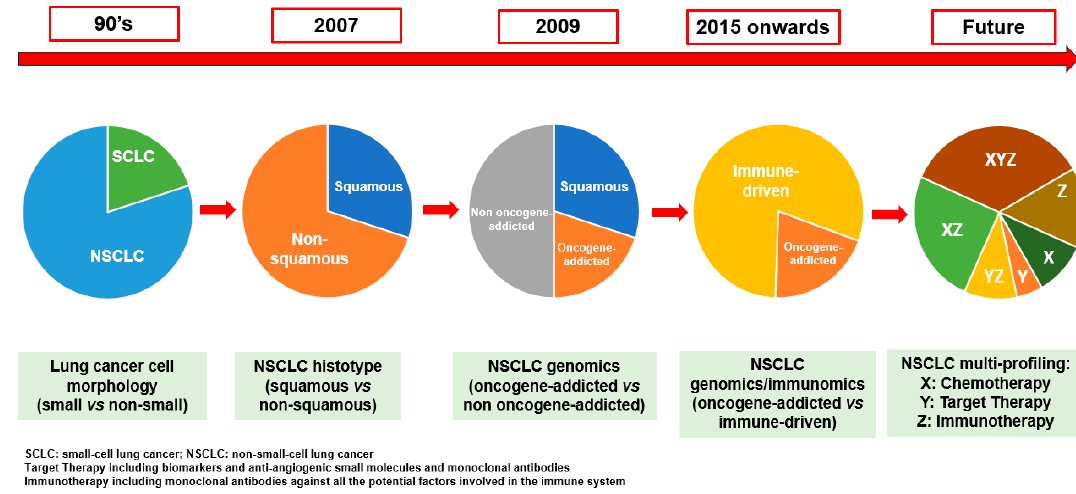
Figure 1. The evolution of paradigm shift of first-line treatment of fit metastatic non-small-cell lung cancer (NSCLC) patients.